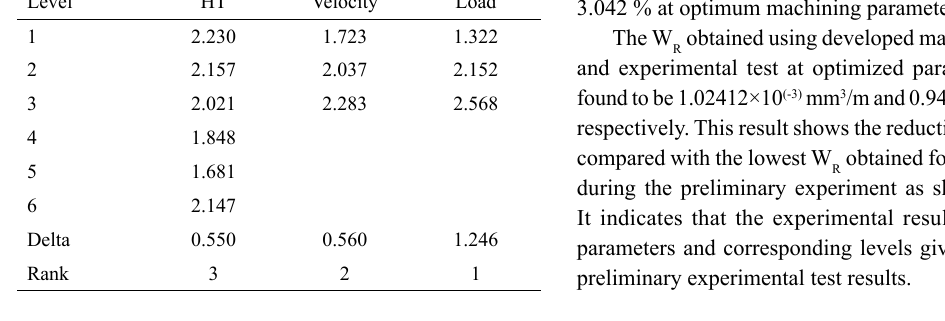
Table 7. ANOVA for means of wear rate.